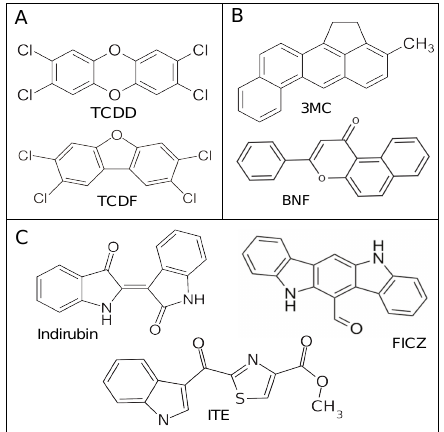
Figure 1. Structures of the AhR agonists examined for species specificity. ( A ) Halogenated aromatic hydrocarbons (HAHs); ( B ) Polycyclic aromatic hydrocarbons (PAHs) and PAH-like; ( C ) indole-containing